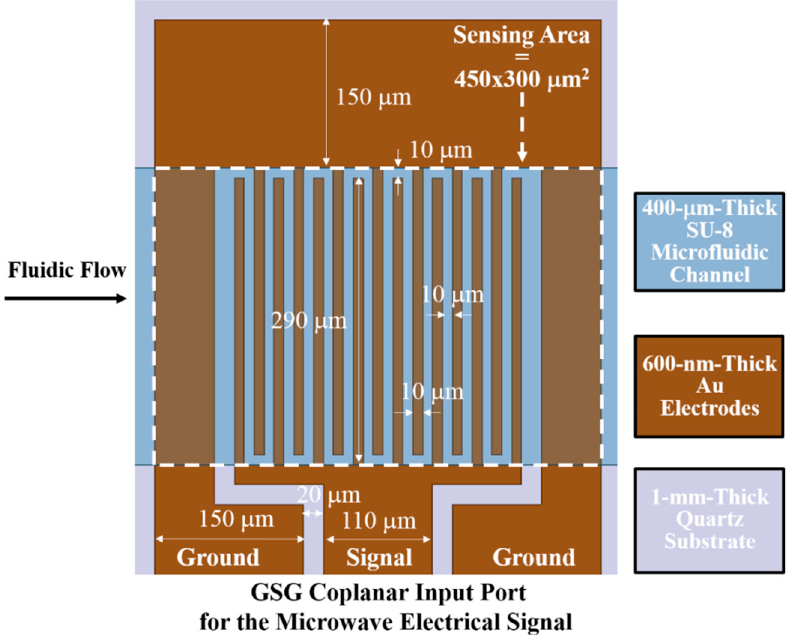
Figure 1. Top-view of the studied microfluidic biosensor based on one-port interdigital capacitor with 15 fingers in the sensing area. Table 1. Comparison of various studies reporting on the investigation of fluidic IDC biosensors. Channel-Electrode-Substrate Reference